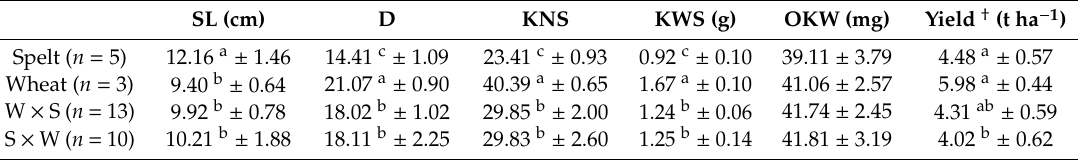
Table 2. Mean values ( ± standard deviations) of spike length, spike density, kernel number per spike, kernel weight per spike, one-kernel weight and the yield of the examined hybrids and their parental forms in two years of the